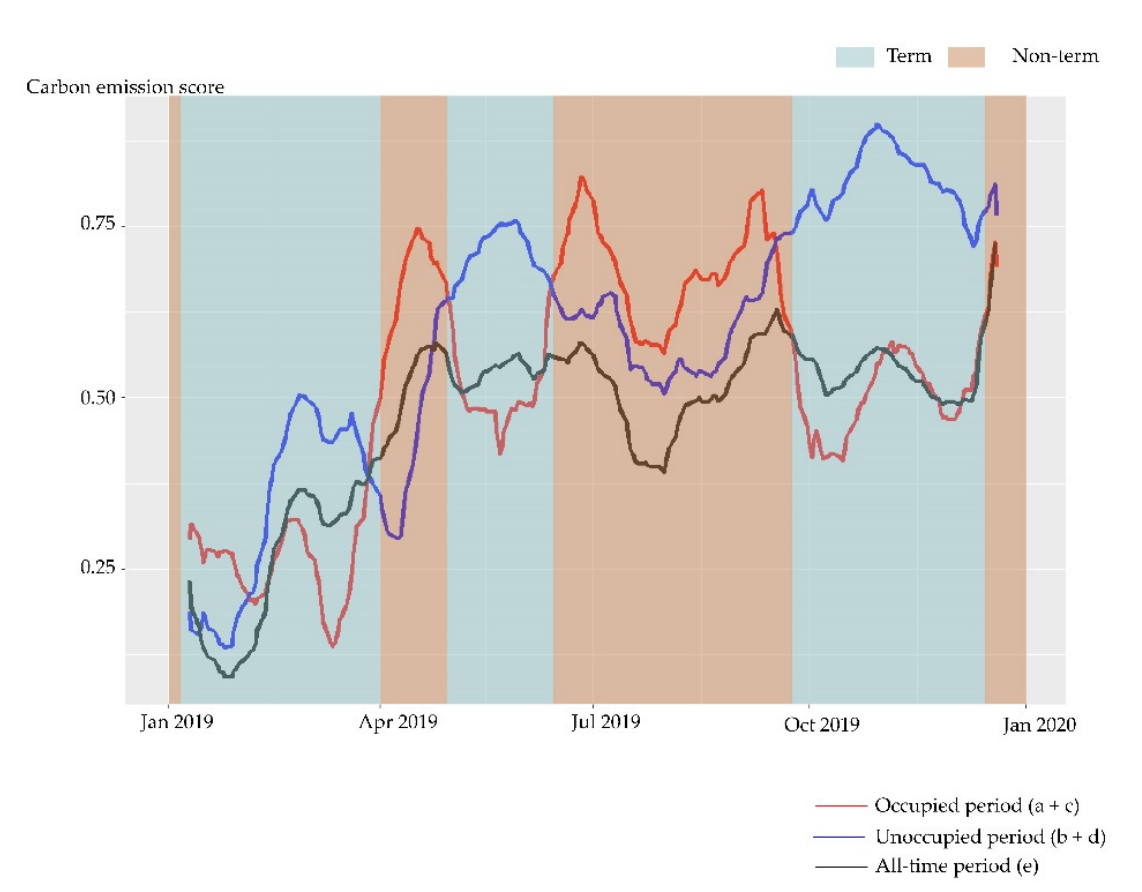
Figure 5. The 15-day rolling average of the carbon emission score.